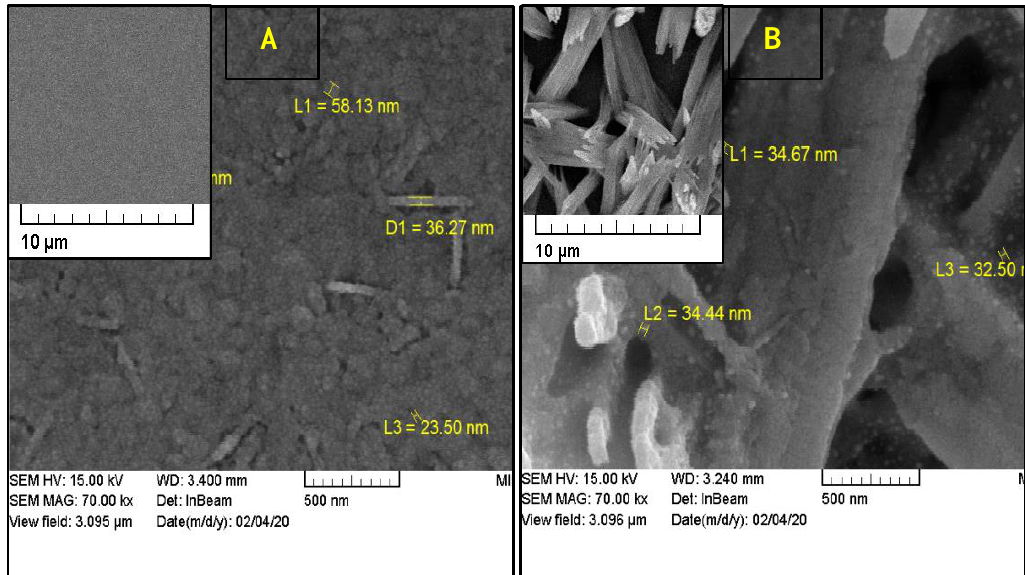
Figure 5: Top-view of FE-SEM images for PSK layer, A: PSK with C.B anti-solvent, B: PSK without C.B anti-solvent. L1, L2 and L3 are the grain sizes and D1 is the rod diameter.